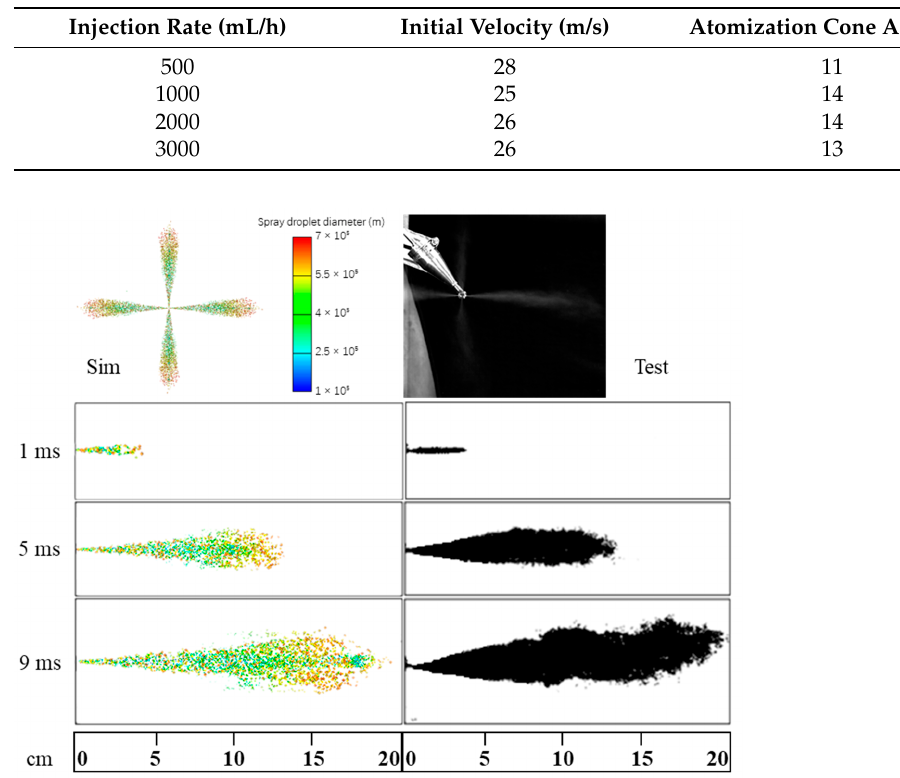
Figure 8. Diagram of high-speed photography test. Table 3. The droplet initial velocity and atomization cone angle of different urea injection rates. Injection Rate (mL/h)